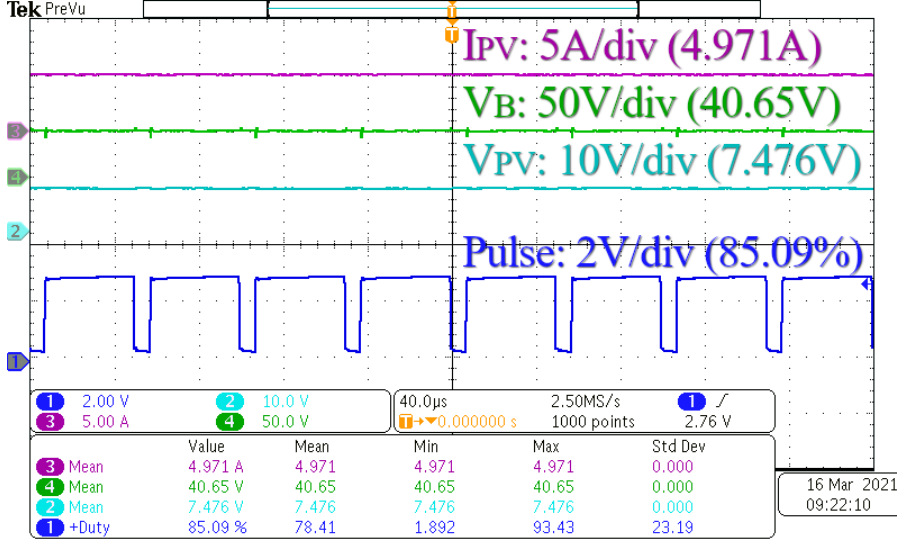
Figure 9. Experimental voltage regulation at 838 W/m 2 and 32 °C.